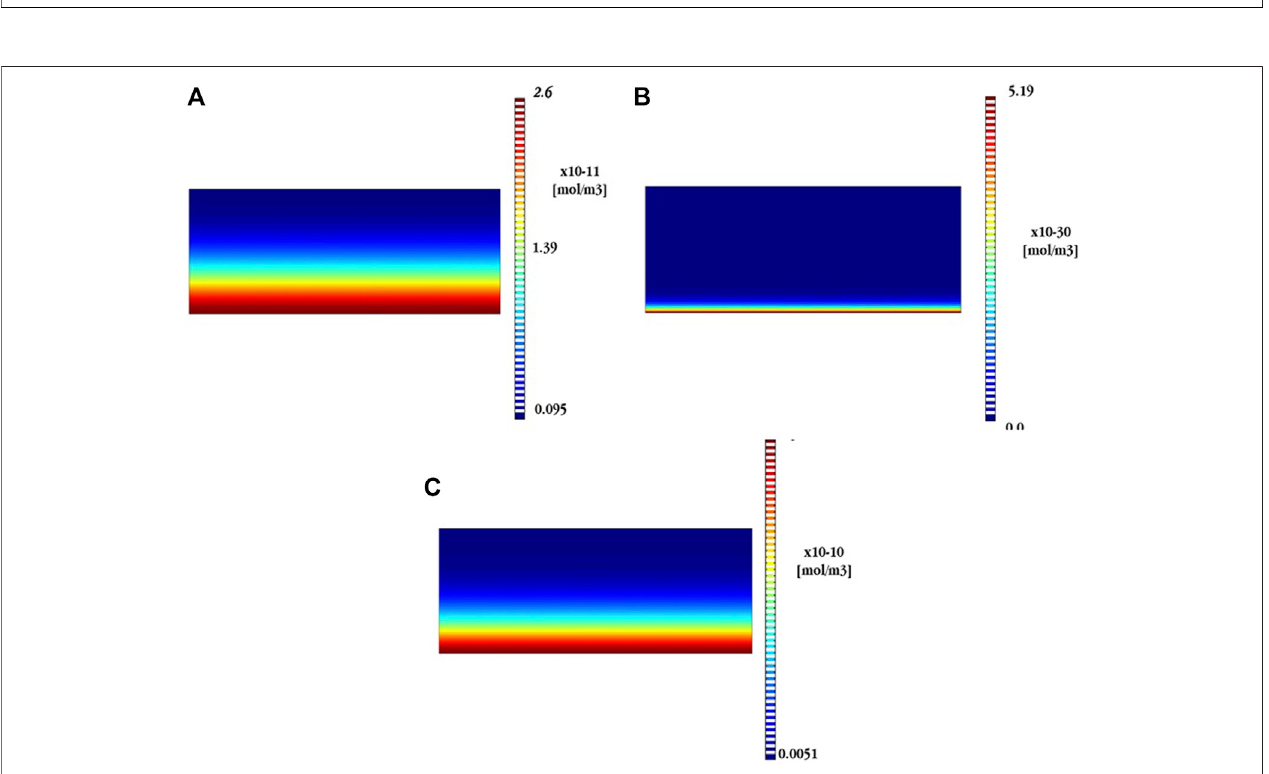
FIGURE 8 | Numerical results for the generation of (A) Zn(OH) 2 , (B) Zn 5 (OH) 8 Cl 2 , and (C) CaZn 2 (OH) 6 compounds on top of the Zn surface after 24 h in a chloride dilute electrolyte (0.03% Cl (cid:1) ).